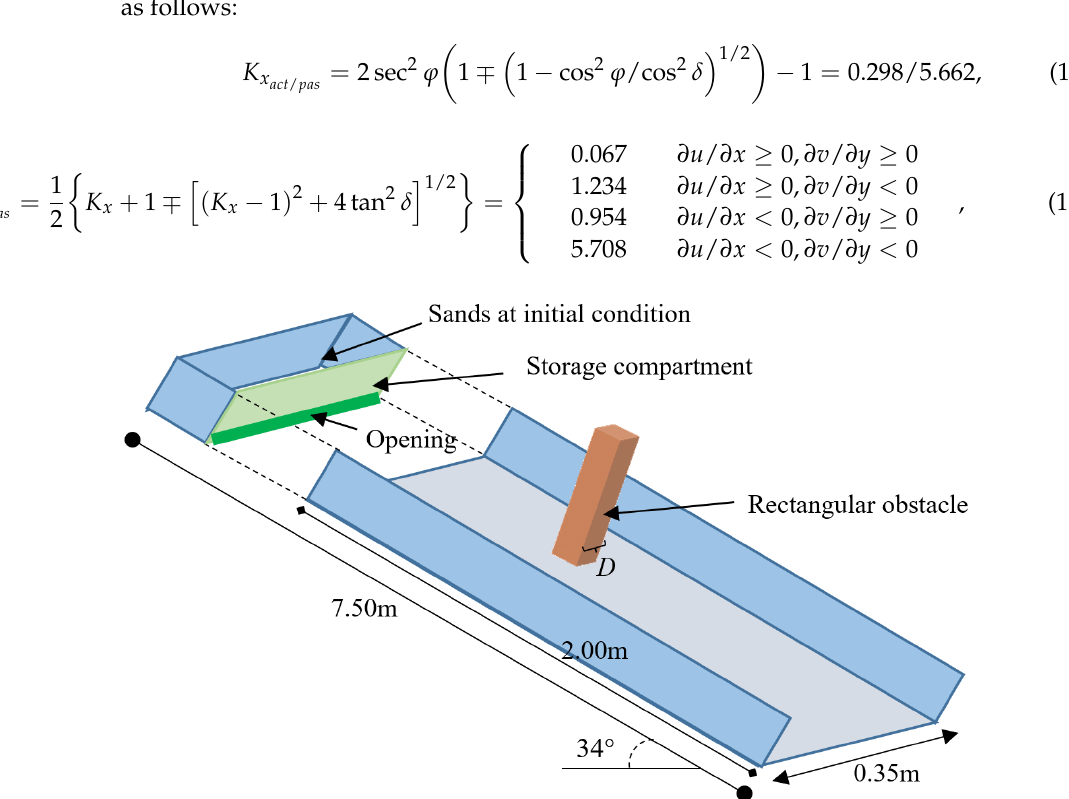
Figure 1. Schematic of the laboratory installation; grains initially stored in a compartment were released from a 70 mm high opening to simulate a granular stream striking a rectangular obstacle during the flow process.